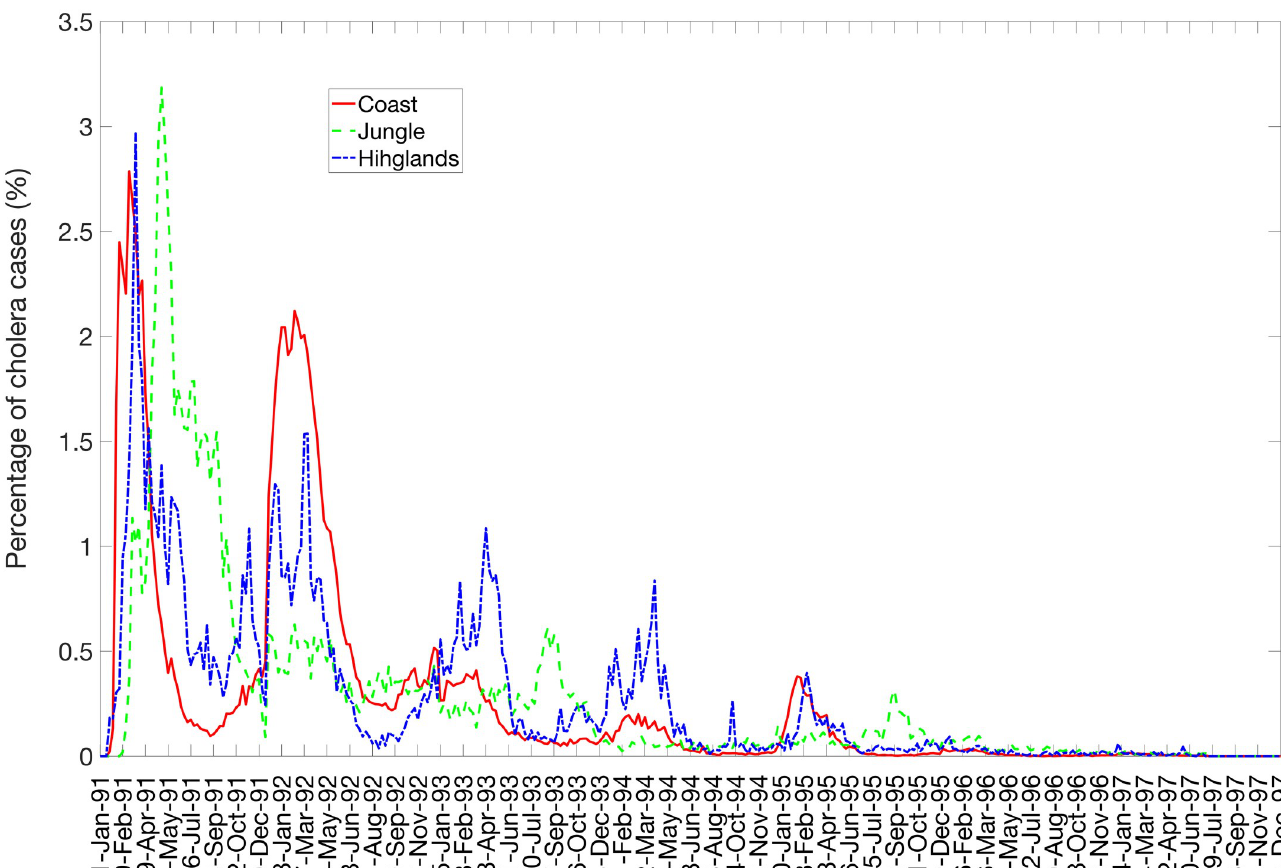
Fig 2. Weekly incidence of cholera cases in Peru by region, January 1991 through December 1997. Curves represent the national and regional weekly proportions of total cases reported during